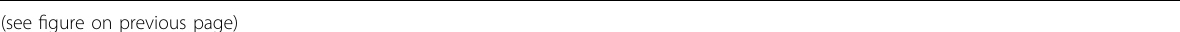
Fig. 5 Resistance elevates Nrf2, BDNF expression and inhibits HDAC2, mSin3a, and MeCP2 expression. A , B Schematic of social defeat stress model and the schedule of treatment. C Thermal imaging of mice trajectories. D The social interaction test for no target and target time (mean ± SEM, n = 4 – 6 per group, one-way ANOVA, * p < 0.05, ** p < 0.01). E The ration for target and no target time (mean± SEM, n = 4 – 6 per group, one-way ANOVA, * p < 0.05, ** p < 0.01). E , F The western blot analysis for mPFC and hippocampus. The western blot was performed for Nrf2, BDNF, HDAC2, mSin3A, and MeCP2 in mPFC and hippocampus (mean ± SEM, n = 4 per group, one-way ANOVA, * p < 0.05, ** p < 0.01). G The working model of Nrf2- induced BDNF transcription in the model of depression. Stress inhibits Nrf2 expression, which leads to inhibit BDNF transcriptional and abnormal synaptic transmission, causing depression-like behaviors in mice. SFN induces BDNF transcription by activating Nrf2 and could correct the abnormal synaptic transmission, resulting in antidepressant-like